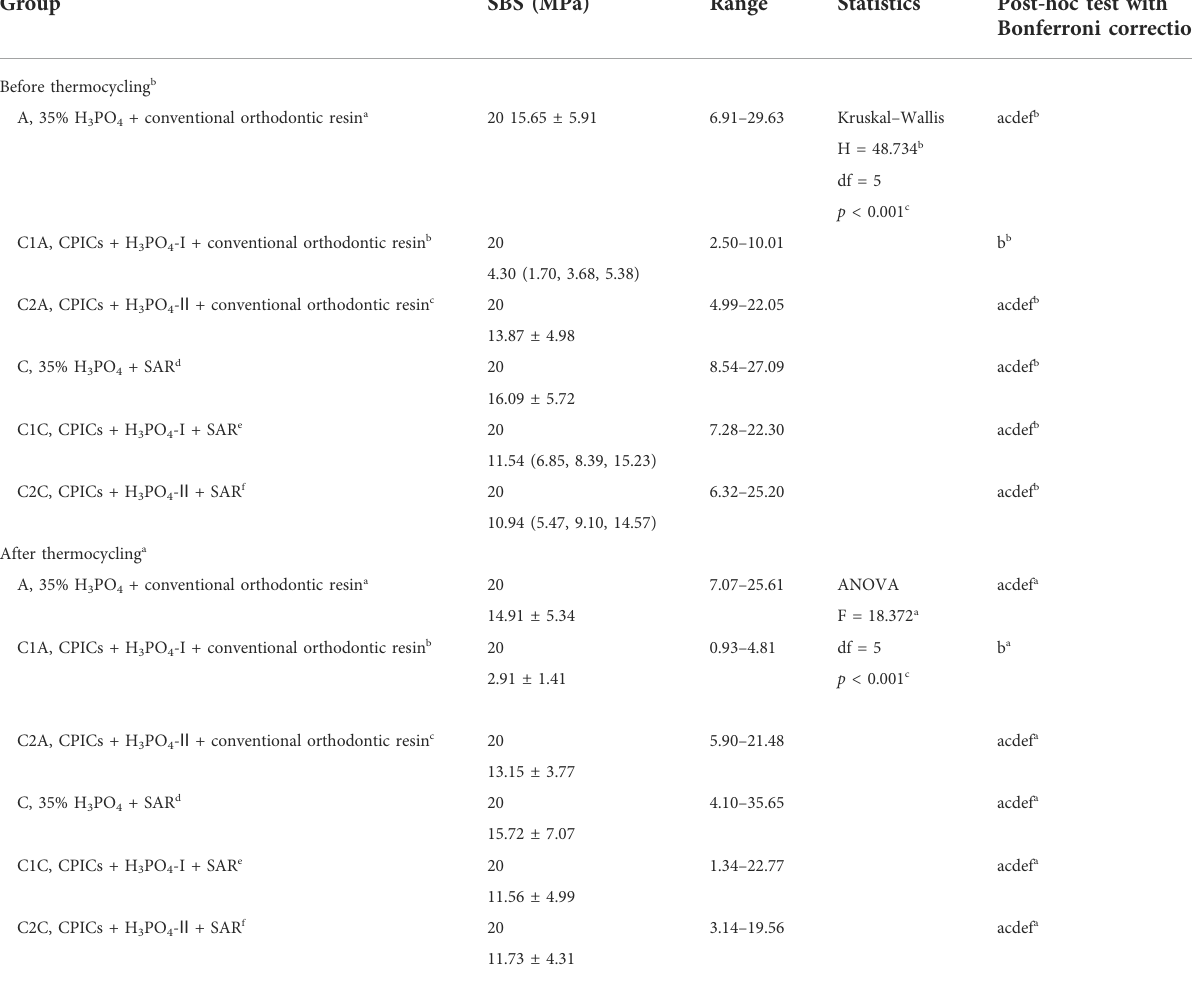
TABLE 1 Comparison of the shear bond strength values for the bracket debonding before and after 10,000 thermocycles.